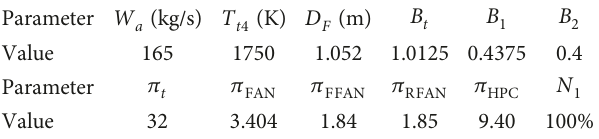
Table 1: Design parameters of three-stream